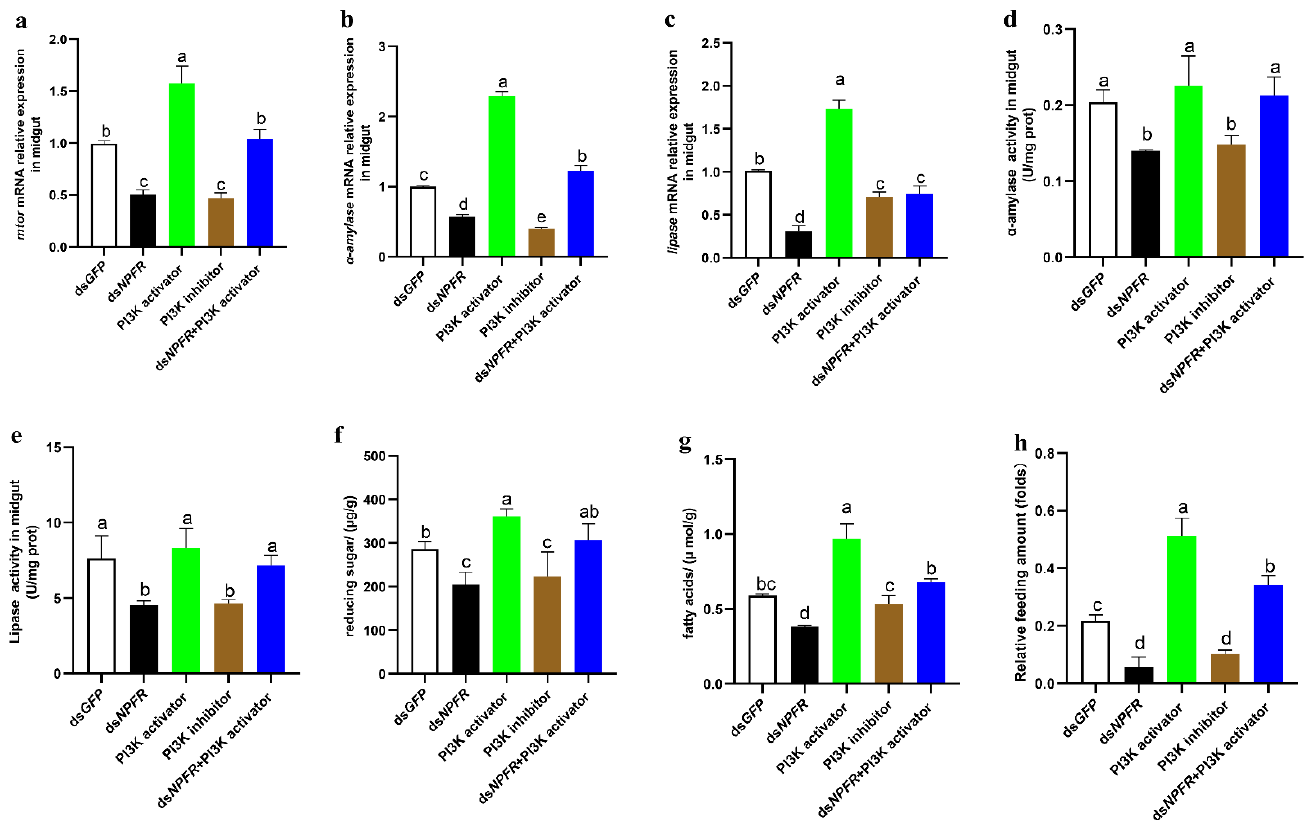
Figure 4. NPF/NPFR regulates digestion enzymes via the PI3K/mTOR pathway in the midgut. All treated 5th instar larvae were reared with the diets ds NPFR , PI3K activator 740 Y-P (1 µM), PI3K inhibitor LY294002 (2 µM), or ds NPFR +PI3K activator for 24 h. ( a – c ) Relative expression levels of mtor , α -amylase, and lipase in the midgut of treated larvae. ( d , e ) Enzyme activities of α -amylase and lipase in the midgut of treated larvae. ( f , g ) Contents of reduced sugars and fatty acids in the midgut of treated larvae. ( h ) Relative feeding amount in the midgut of treated larvae. Each treatment was repeated 3 times with a minimum of 10 individuals each repeat. Different letters above the bars indicate significant differences at p < 0.05 as determined by Duncan’s multiple range test.